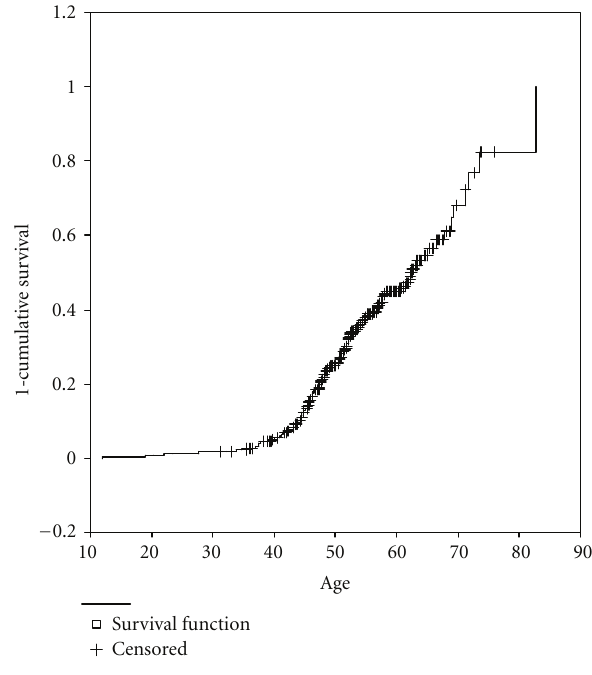
Figure 1: A Kaplan-Meier survival analysis stratified by age of cumulative incidence of cataracts for participants with Down syndrome.